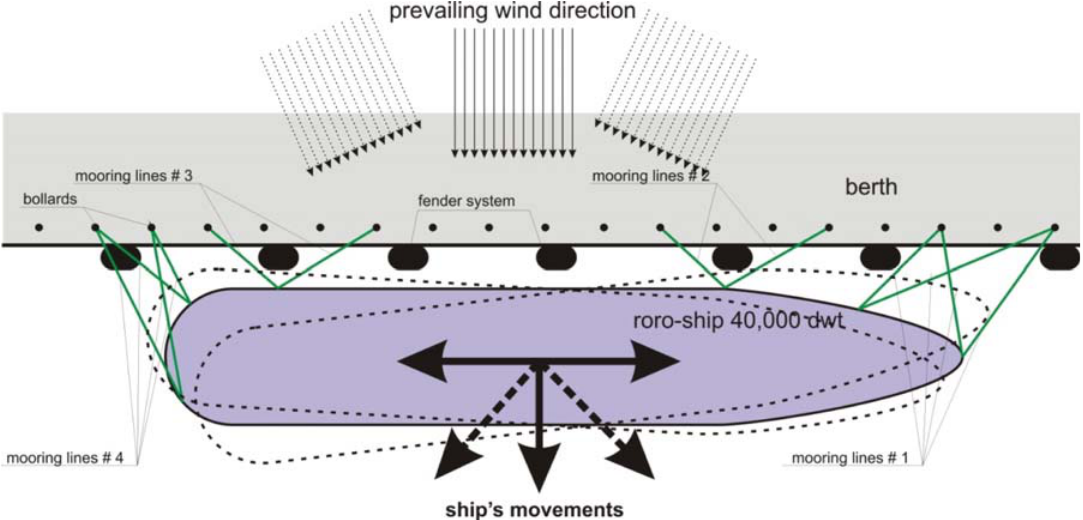
Fig. 16. A typical mooring scheme of a